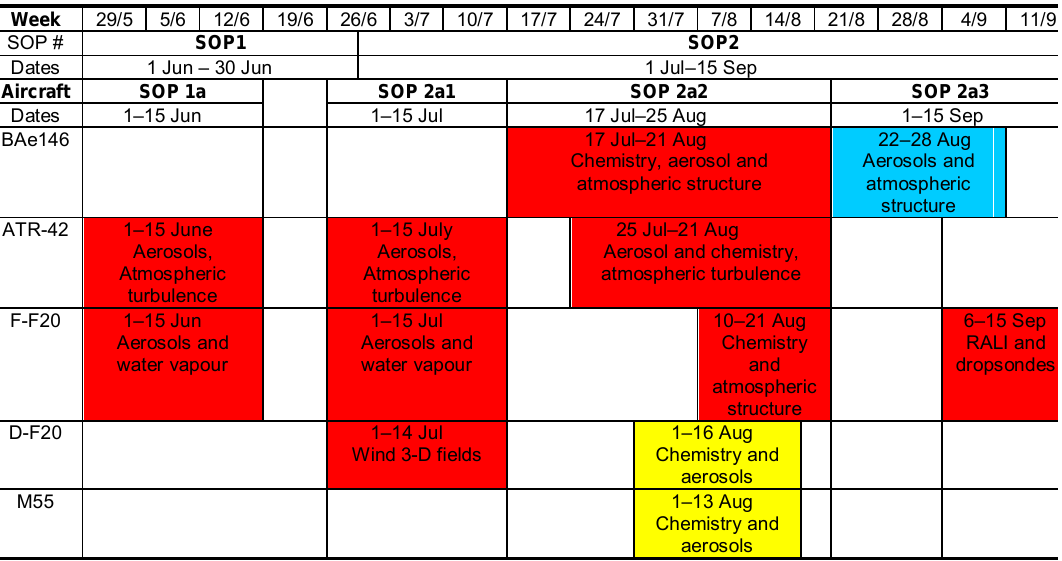
Table 1. Aircraft detachment periods for each SOPs 1 & 2. The names of the aircraft campaigns that took place within the wider AMMA SOPs were given the suffixes “aN” where “a” signifies “aircraft” and “N” is the number of the aircraft campaign within that SOP. Operational bases are colour-coded (red = Niamey, blue = Dakar, yellow = Ouagadougou).